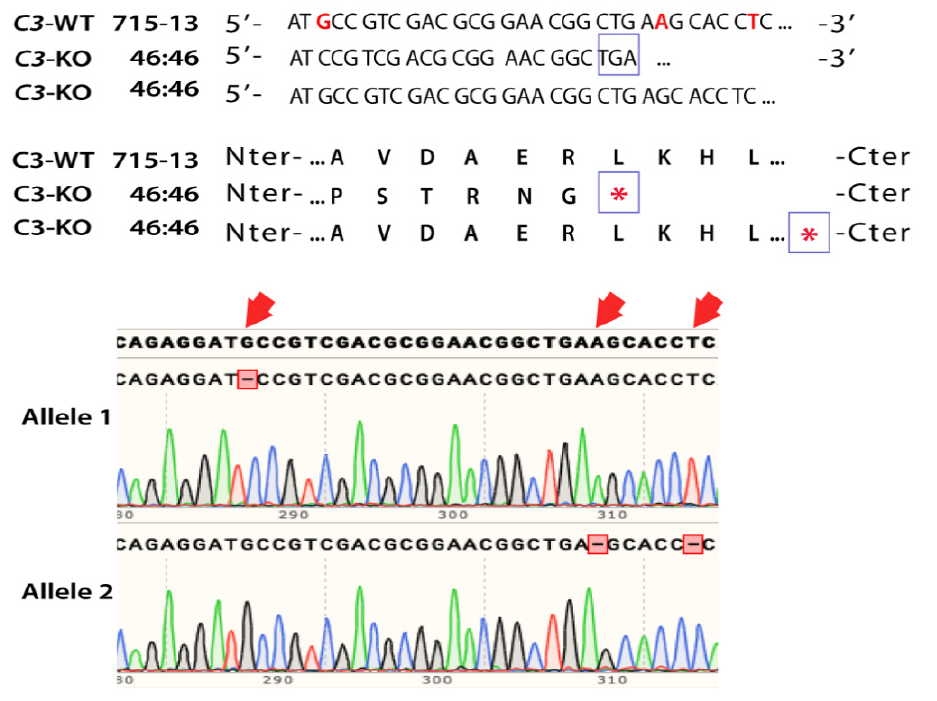
Figure 1. CRISPR edited iPSC-RPE cells C3 WT/WT and C3 KO/KO . DNA sequence of the iPSC clone 715-13 ( C3 WT/WT ) and 46:46 ( C3 KO/KO ). Red bases represent the ones deleted in the knockout clone used for the studies. Sanger sequencing analysis show frameshift deletions (red font, red arrows) in both alleles that result in premature STOP codons (*). The STOP codon in allele 2 is 24 bp downstream of the PAM sequence, but the protein sequence was shortened to simplify the figure. See Supplementary Figure S1.